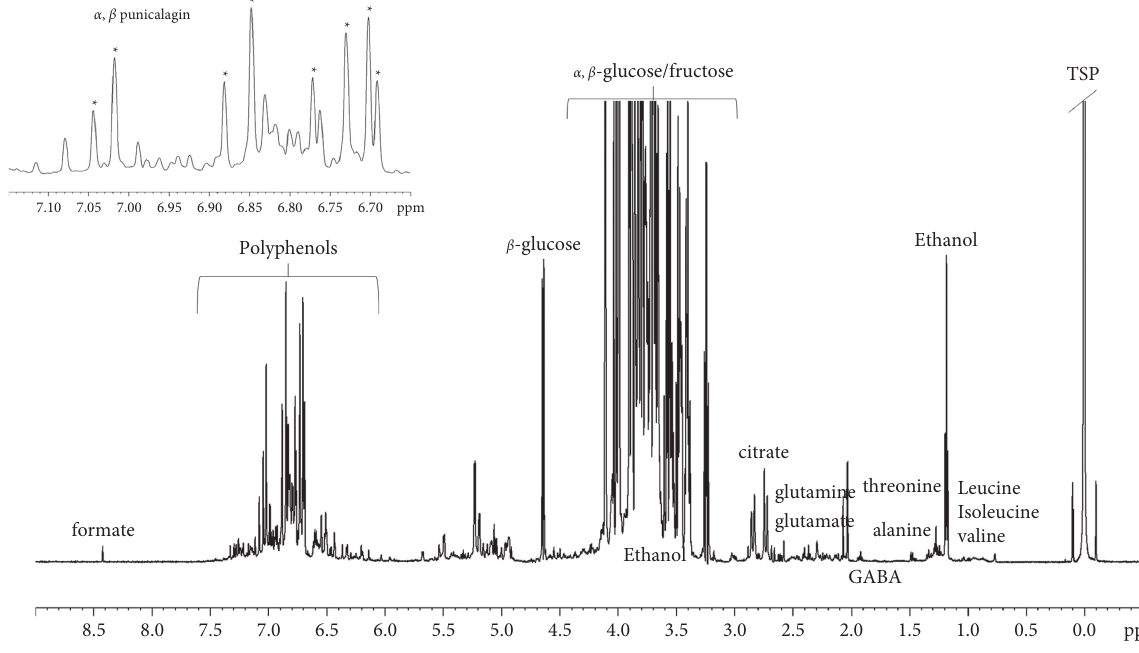
Figure 4: 1 H zgcppr NMR spectrum of PAE in D